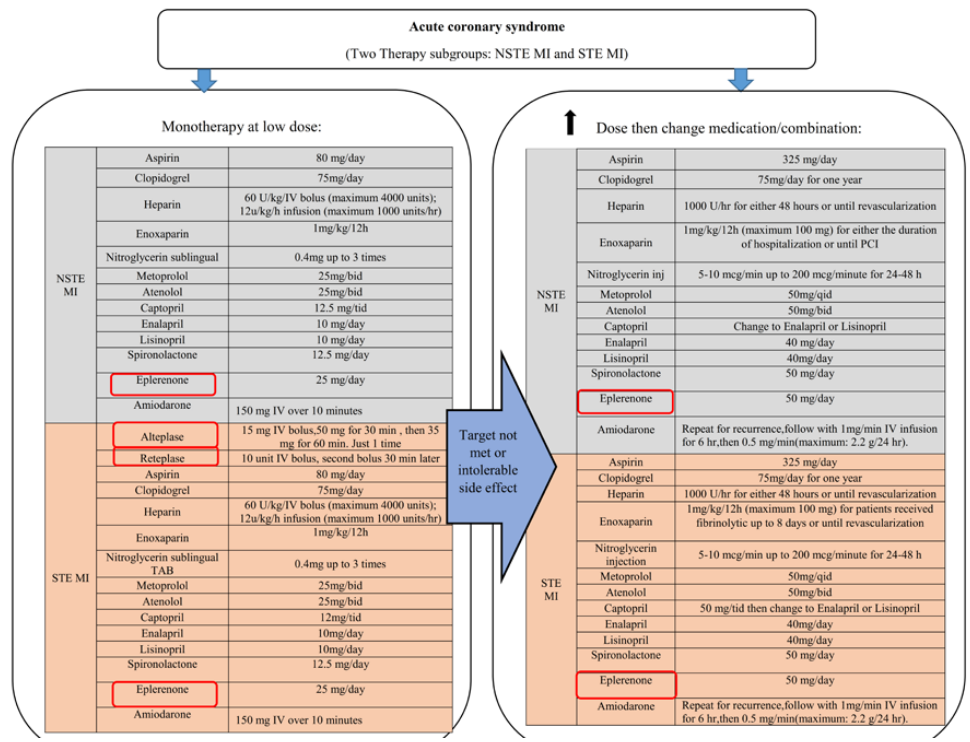
Figure A1. The di ff erent medication therapy scenarios in acute coronary syndrome